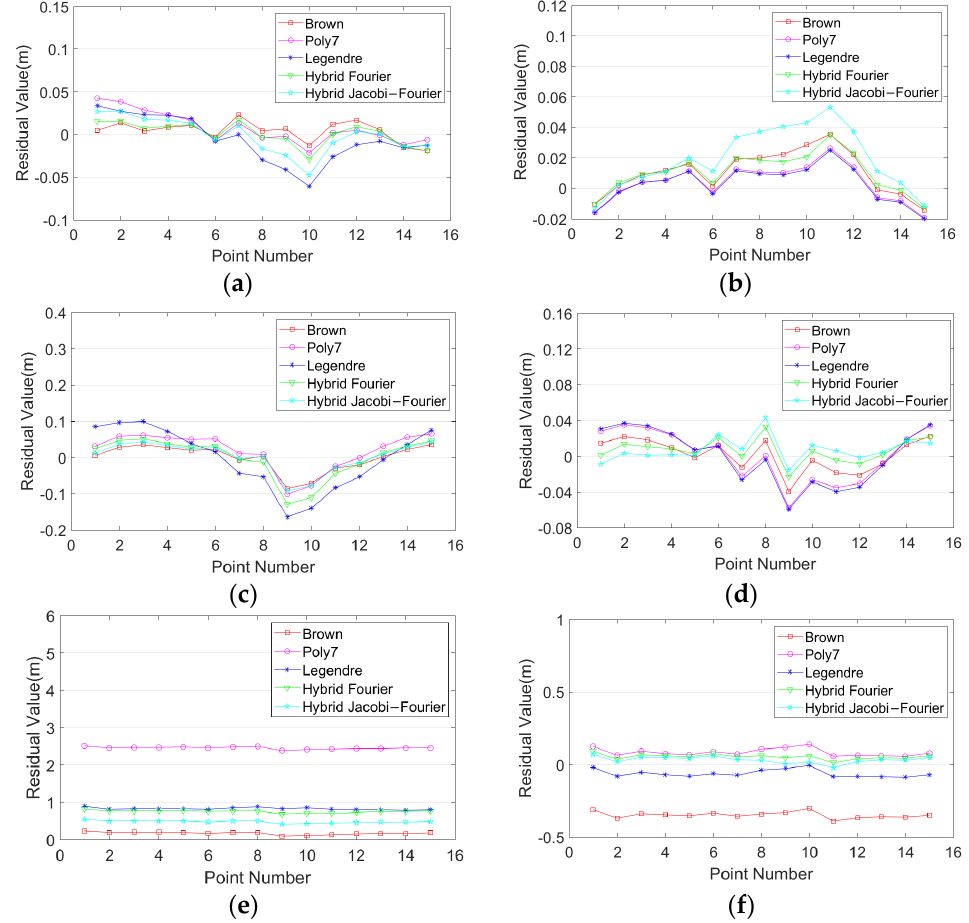
Figure 7. The residuals of check points after self-calibration for test site 1. ( a , c , e ) The residuals of check points of the rectangle dataset in the direction of X, Y, and Z, respectively; ( b , d , f ) the residuals of check points of the S-shaped dataset in the direction of X, Y, and Z, respectively.